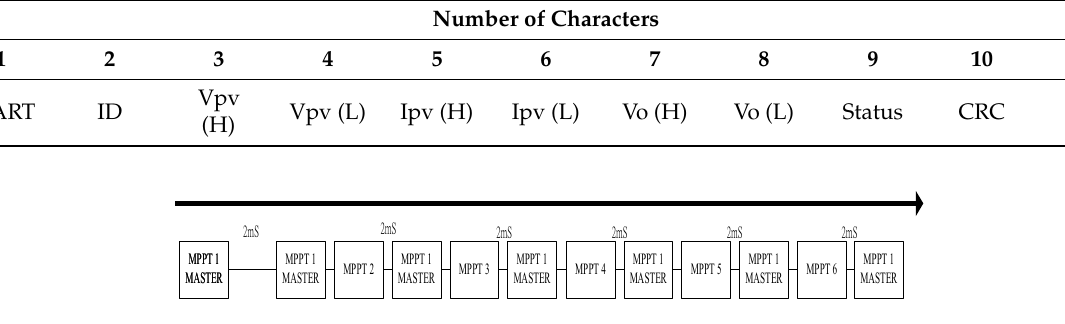
Figure 8. RS-485 communication time sequence diagram.